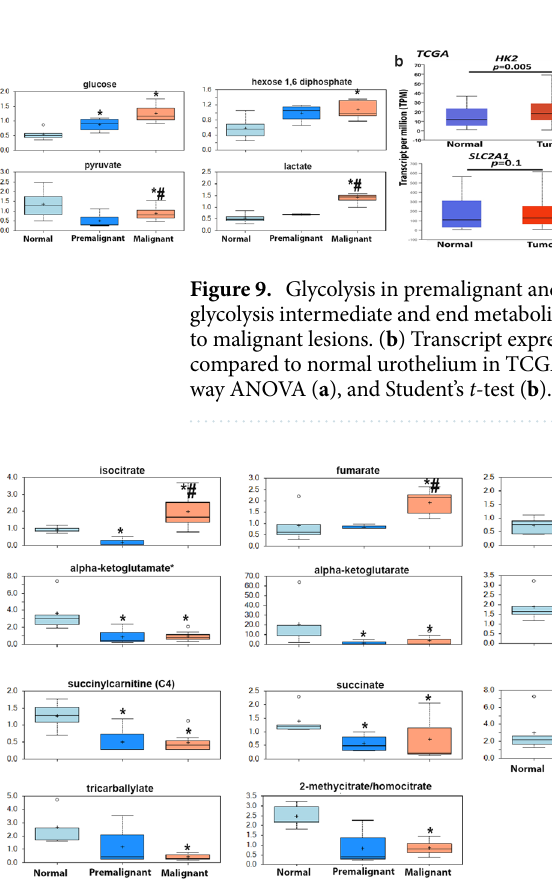
Figure 10. TCA cycle metabolites in premalignant and malignant murine lesions: Box plots show the expression of ( a ) TCA cycle metabolites. ( b ) glutamine, glutamates, asparagine and aspartate in premalignant and early malignant bladder lesions. * p < 0.05 compared to normal bladders (n = 5). # p < 0.05 comparing premalignant lesion (n = 4) to early malignant/NMIBC (n = 7); one-way ANOVA with multiple